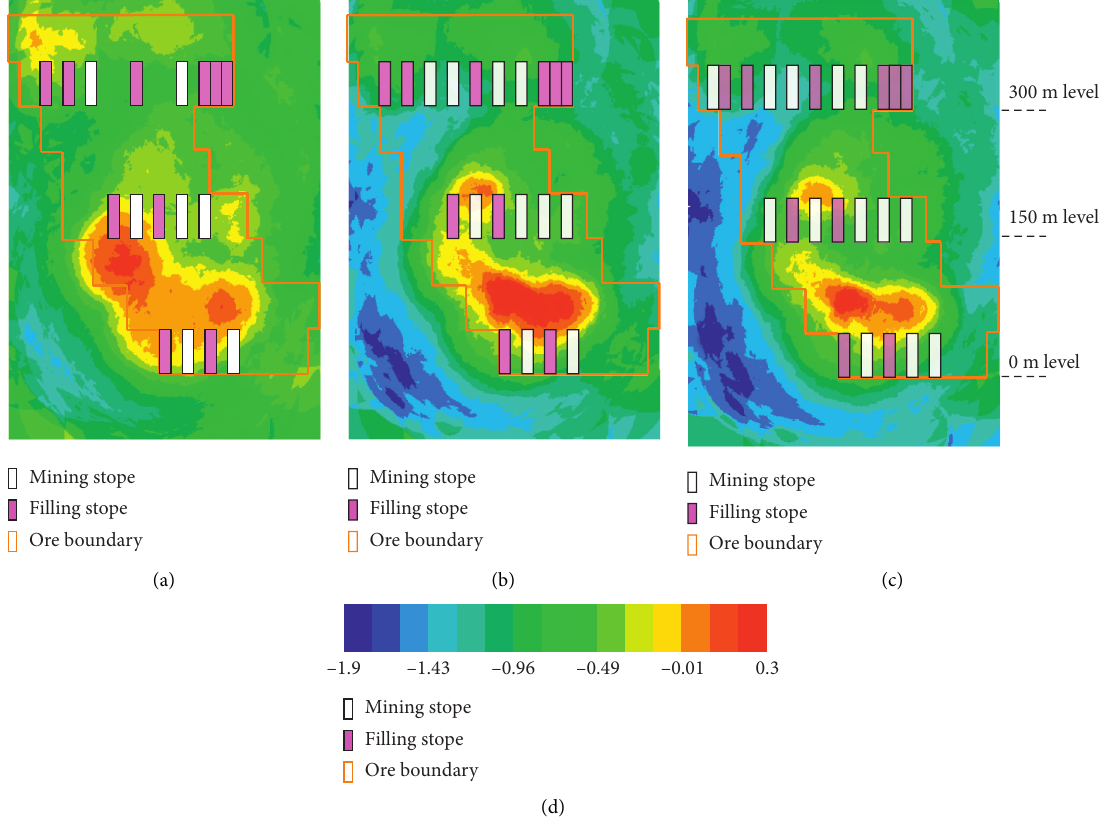
Figure 3: Cloud chart distributions of lg ( EI ). (a) 2017.6. (b) 2017.9. (c) 2017.12. (d) Legend.